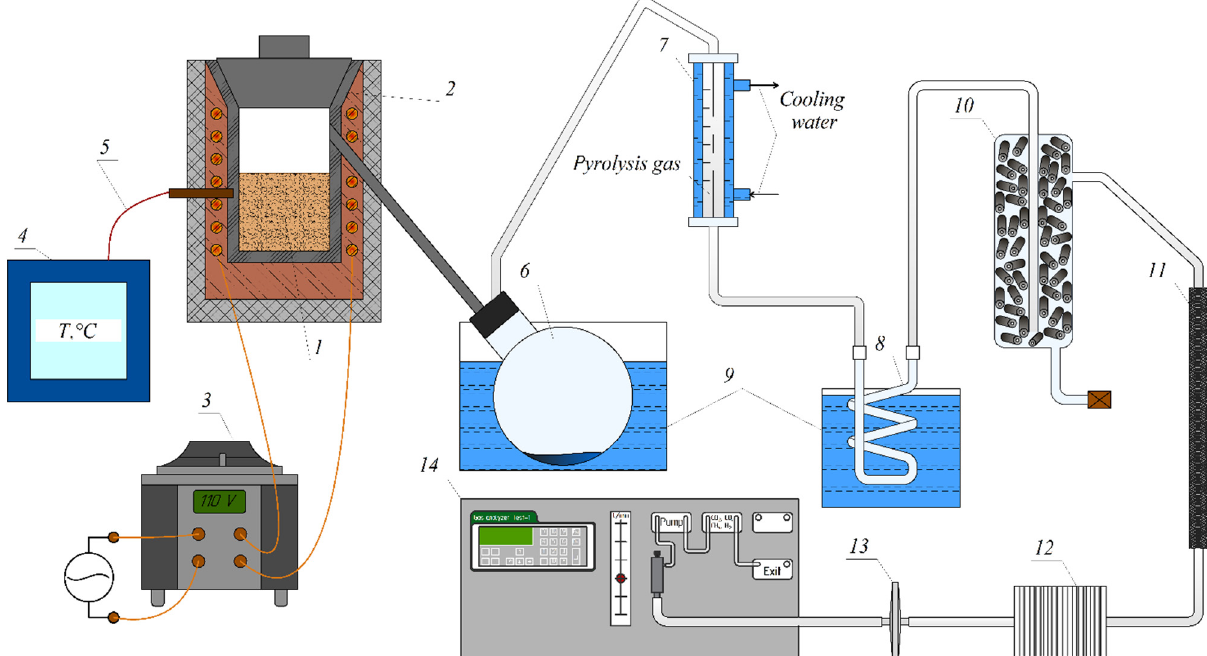
Figure 2. Laboratory device for the pyrolysis gas analysis: 1—Siberian pine nutshell, 2—reactor, 3—